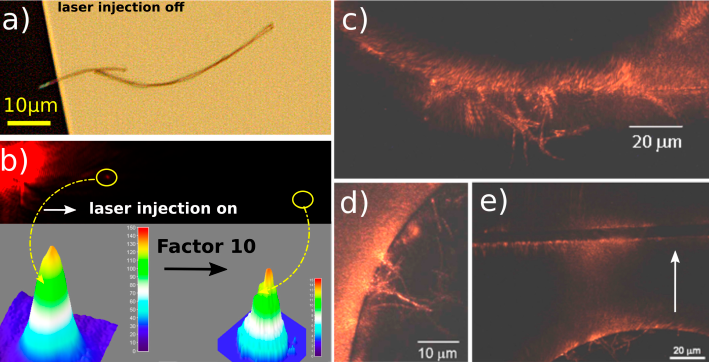
Figure 5. Evanescent coupling between SU8 micro- and nano-structures. ( a ) Top-view of a single nanotube positioned close to a second one. ( b ) Corresponding image during laser injection. The propagation along the first nanotube and the coupling and propagation into the second one are attested by the light spots at the end of the NTs, these being highlighted by the two circles. ( c ) Scheme of the configuration of optical coupling between SU8 microdisk and nanostructures and corresponding top-view images during light injection: area (1) coupling between nanotubes positioned at the surface of the SiO2/Si wafer; area (2) coupling with NTs localized on top of the disk; area (3) coupling from a disk-reservoir (where light is injected) to a rib waveguide through propagation along successive NTs. The arrow indicated the direction of light